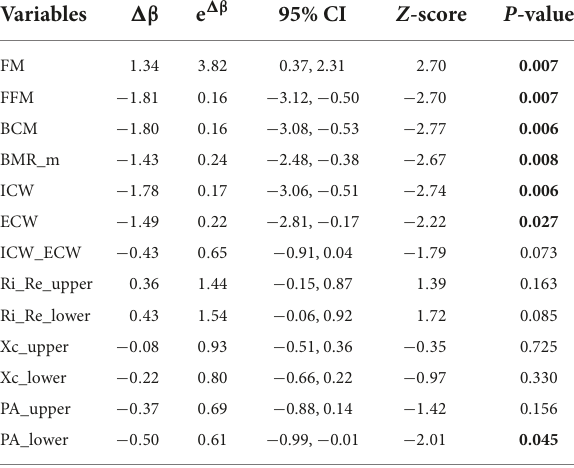
TABLE 4 Odds ratios comparisons between women and